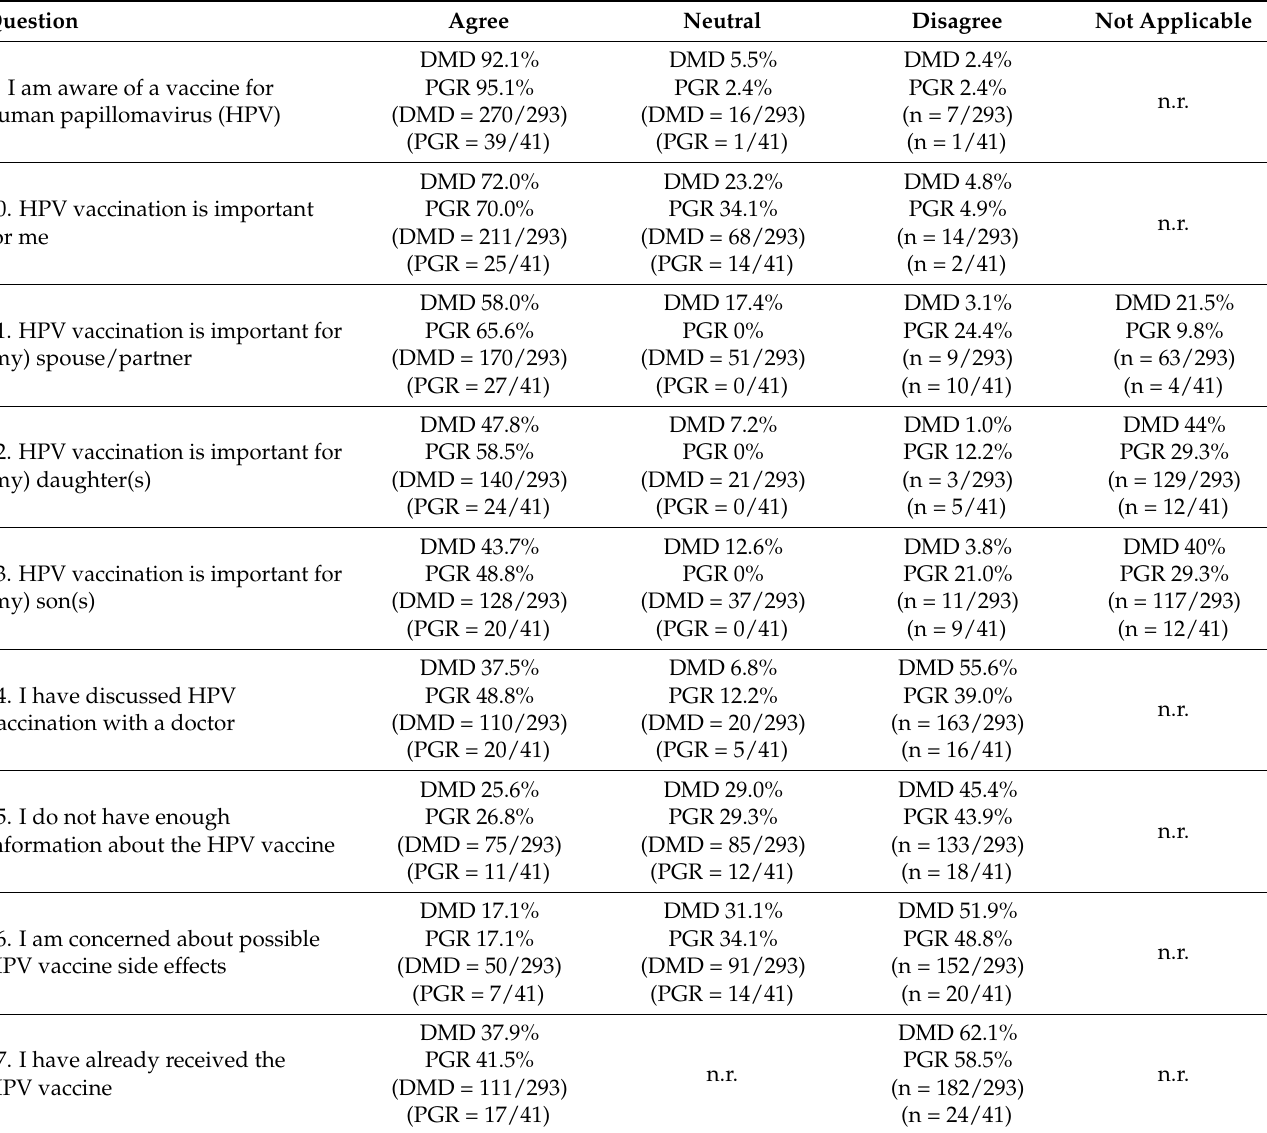
Table 3. HPV vaccine related survey responses of DMD students and